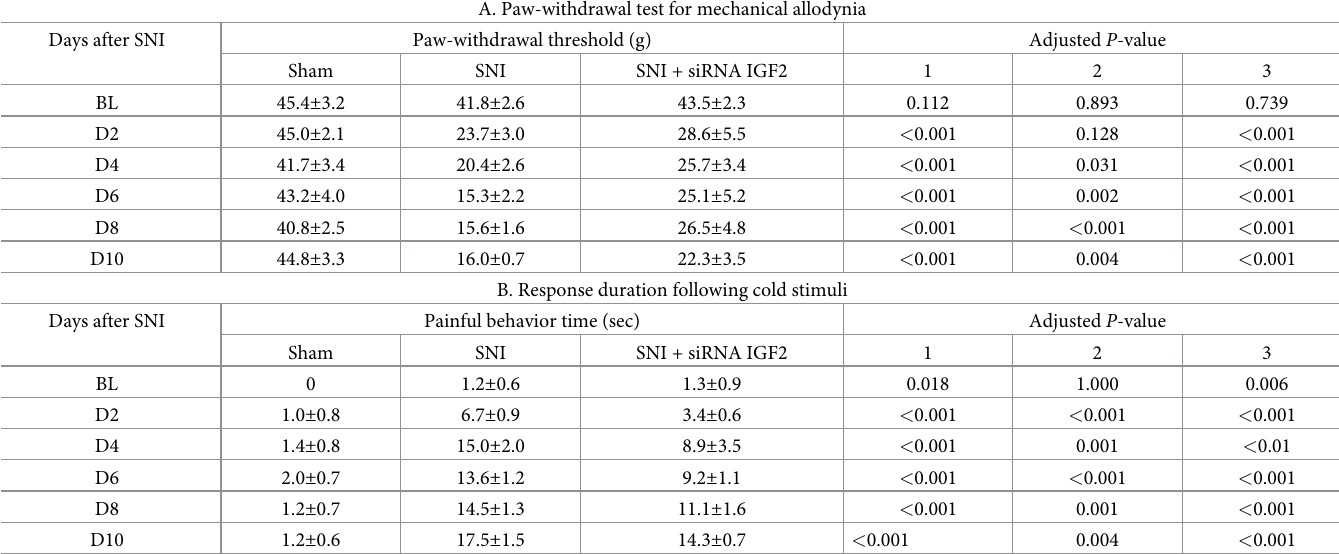
Table 1. Behavioral